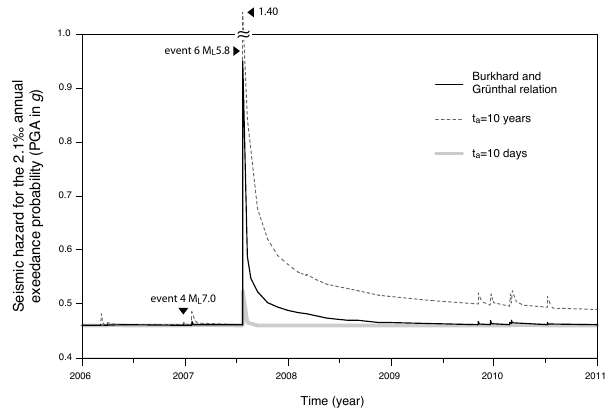
Fig. 7. The acceleration response spectra in Hualien City for the probability of 2.1‰ as a function of the structural period of the two moments. The gray dashed line represents the long-term hazard curve (the short-term rate perturbation is not considered). The black solid line represents the hazard curve one day following the 2007 M L = 5.8 earthquake (event 6 in Table